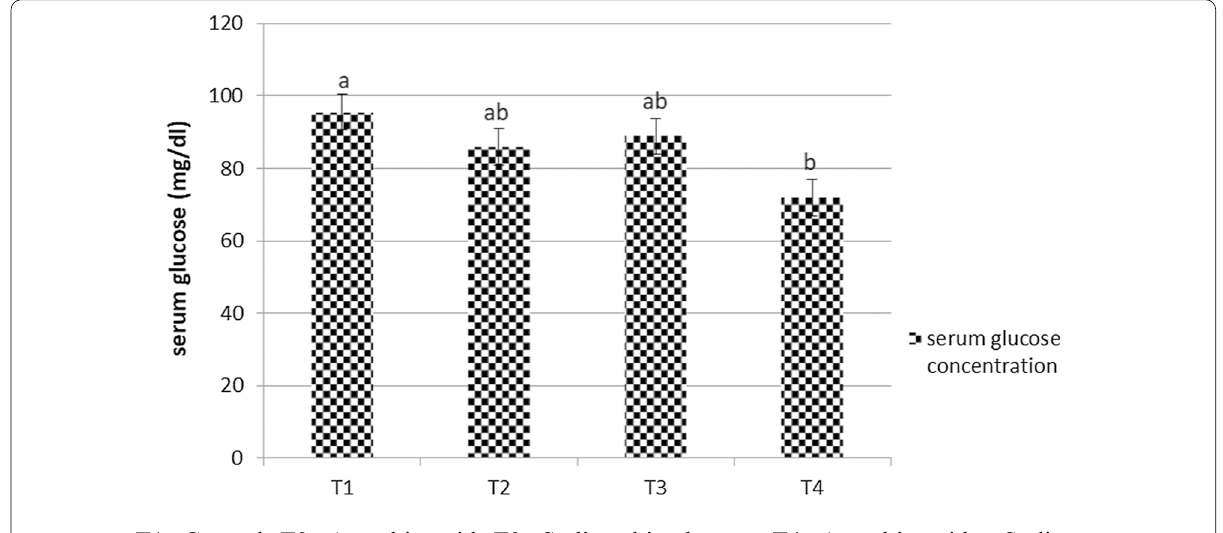
T1- Control, T2- Ascorbic acid, T3- Sodium bicarbonate, T4- Ascorbic acid + Sodium bicarbonate. Fig. 2 Serum glucose level of the rabbit bucks administered ascorbic acid and sodium bicarbonate. T1-control, T2-ascorbic acid, T3-sodium bicarbonate, T4-ascorbic acid Sodium bicarbonate +